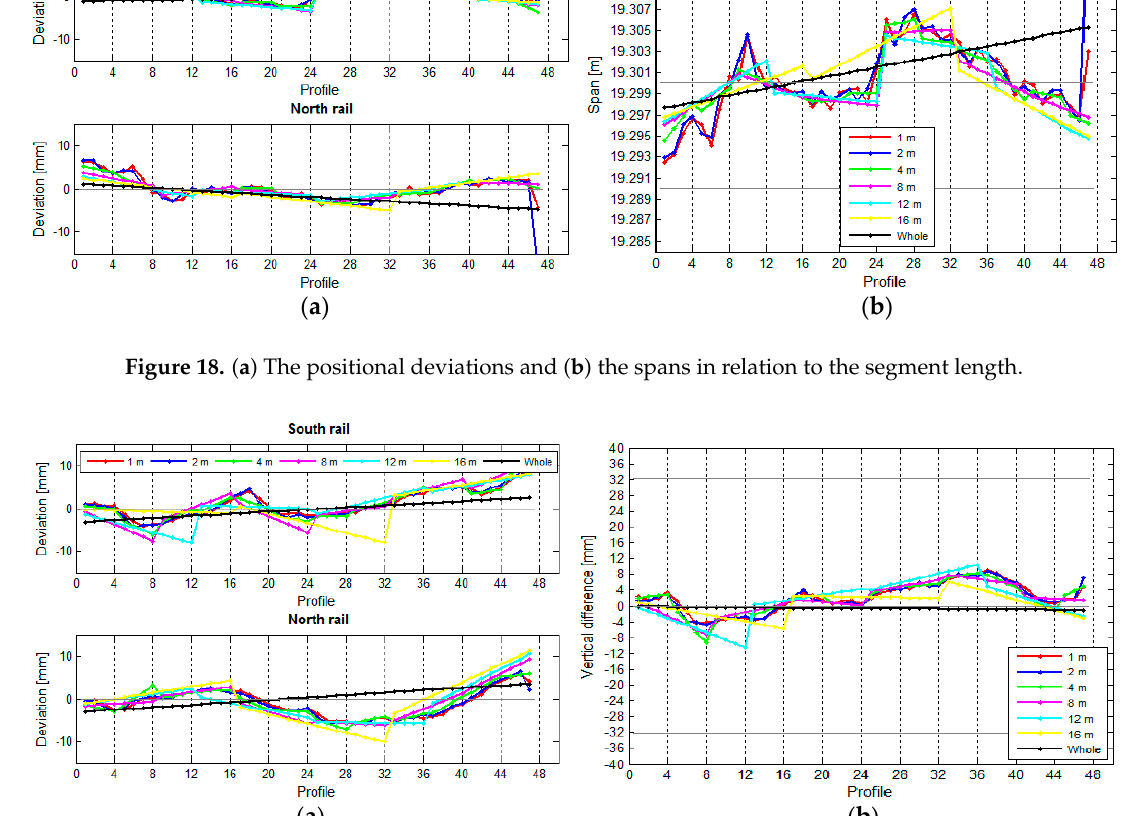
Figure 18. ( a ) The positional deviations and ( b ) the spans in relation to the segment length.